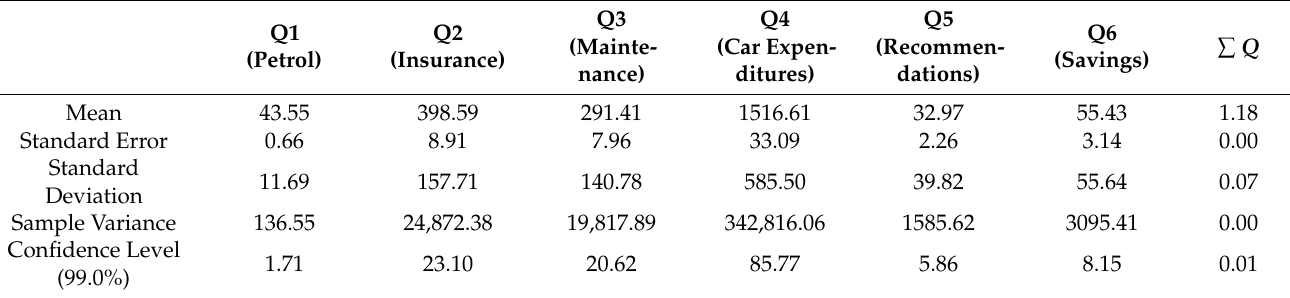
Table 6. Connected car statistical data (Section 2 of the questionnaire).